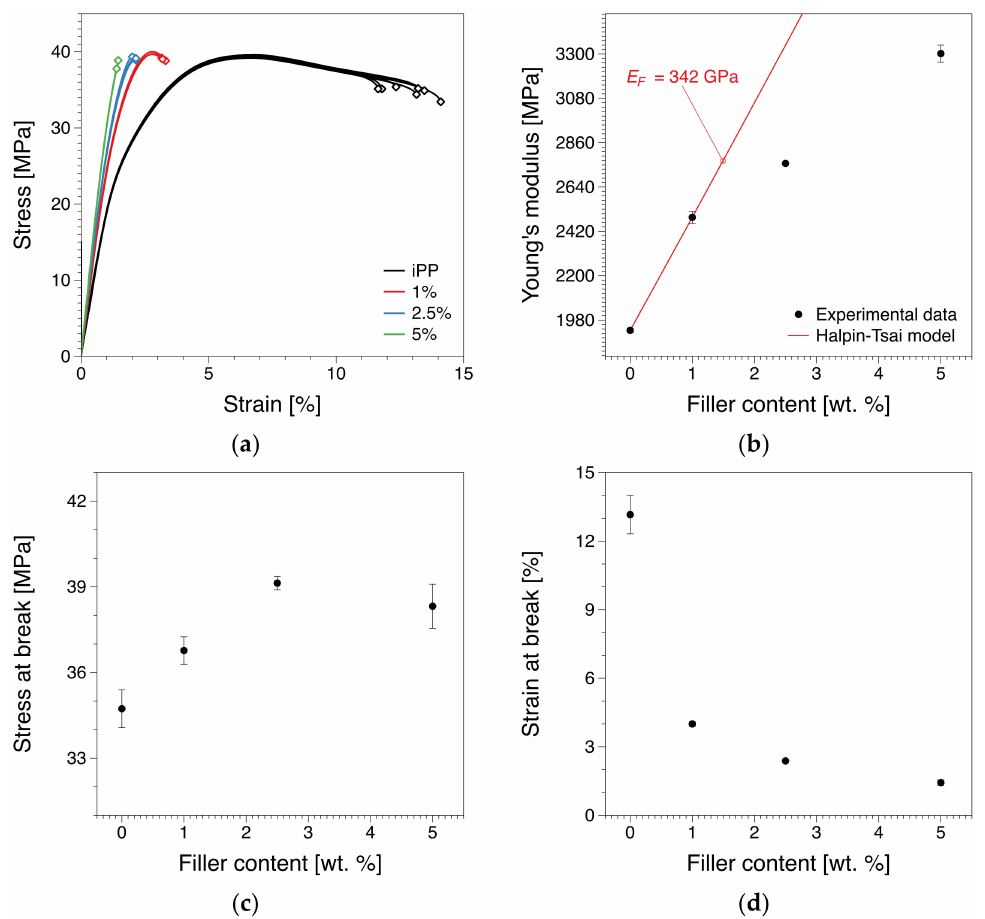
Figure 7. ( a ) Examples of stress-strain curves, ( b ) Young’s modulus experimental values compared with theoretical results computed using the Halpin-Tsai model, ( c ) stress at break and ( d ) strain at break values for the